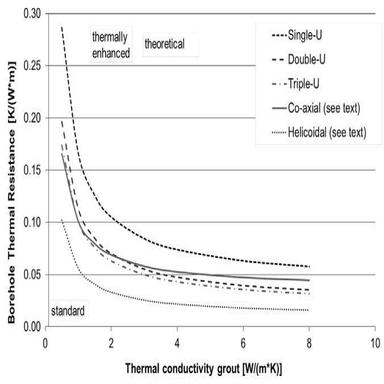
Borehole Thermal Resistance for different configurations versus thermal conductivity of grout (backfilling); helicoidal by approximation only. Data from European project Groundhit.